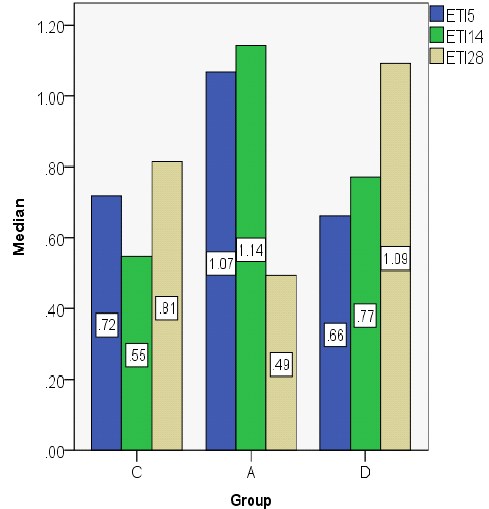
Figure 9. Epithelial thickness index (ETI) value distribution (median).